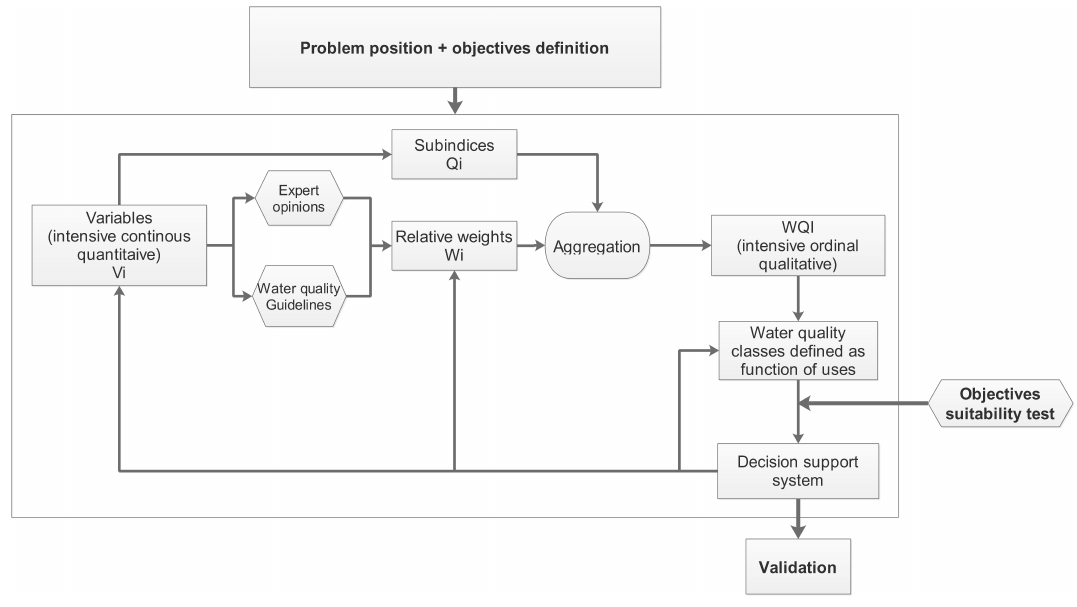
Figure 1. Common steps on WQI